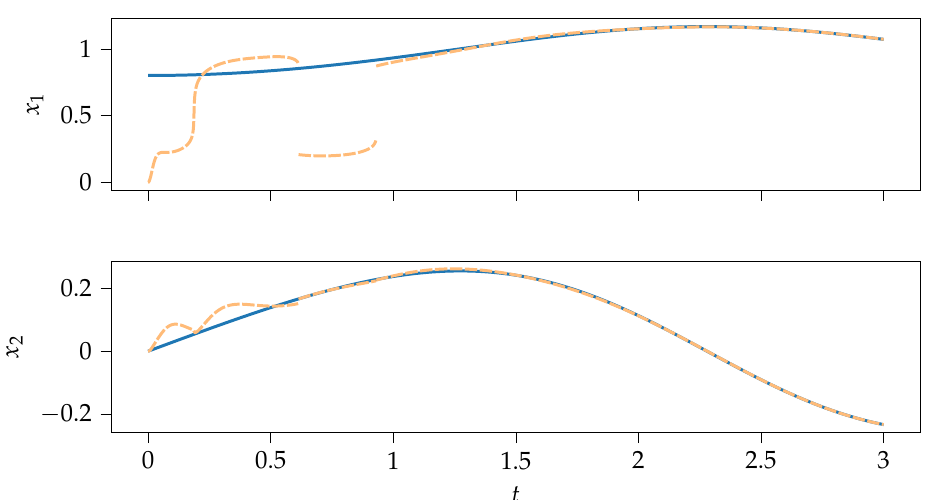
Figure 4. Trajectories for the system state x (blue/dark/solid) and the projected observer state ˆ x (or- ange/lightdashed) of the Duffing oscillator (13). The projection of the observer state is